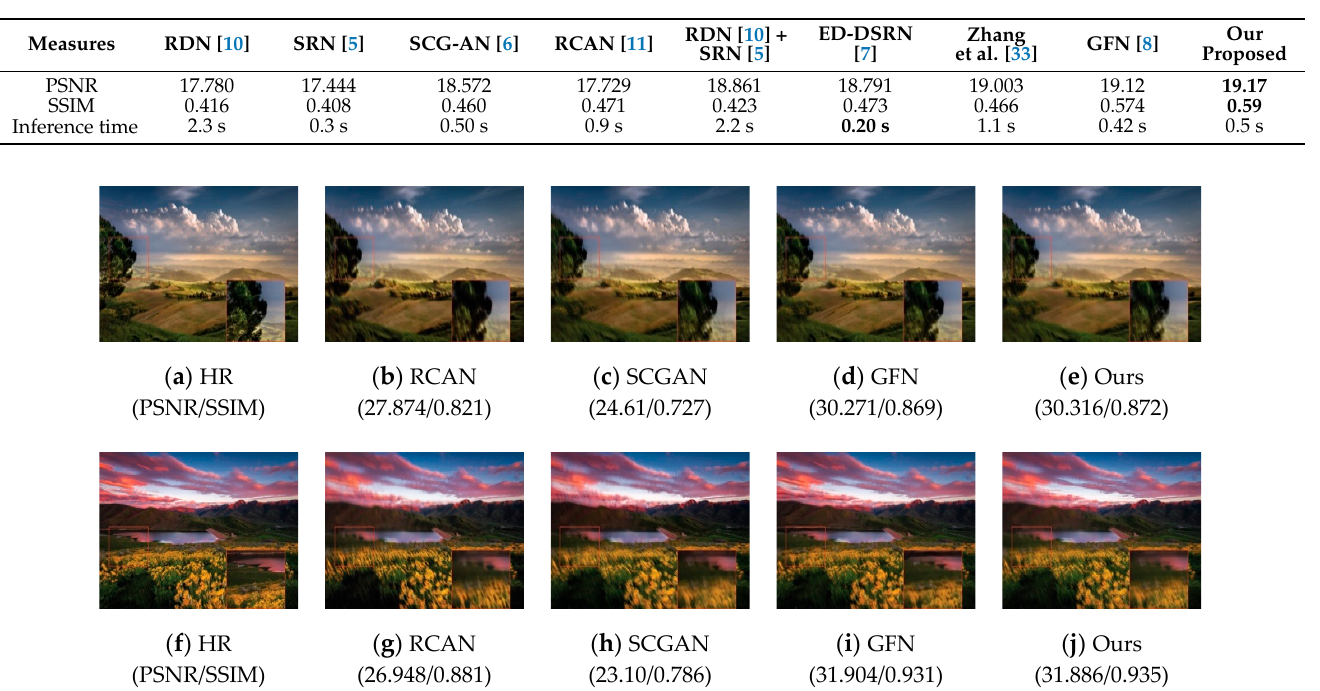
Table 3. The comparisons with SOTA methods of the quantitative performance on Lai et al. dataset [34]. Best results are marked in bold.